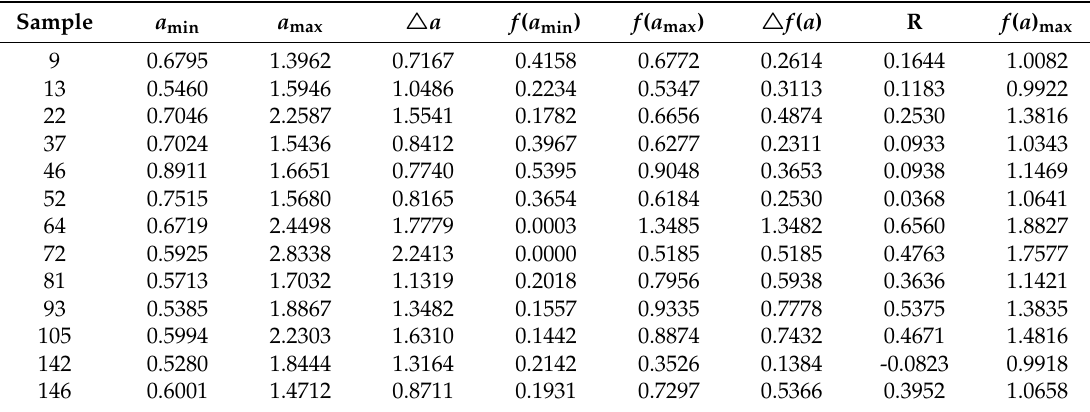
Table 5. Multifractal spectrum parameters obtained from the 13 samples.